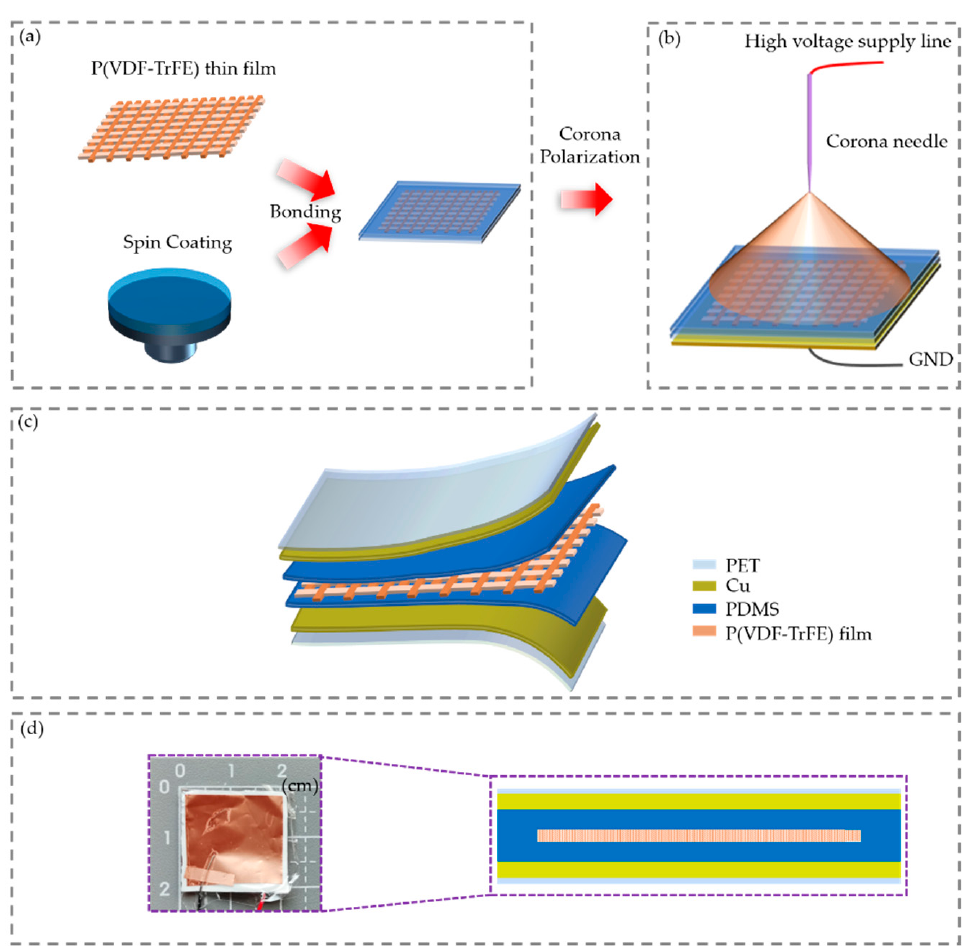
Figure 2. Schematic procedure for fabricating the flexible sensor. ( a ) PDMS sealing as the protective layers and electret layers. ( b ) Corona polarization. ( c ) Diagram of the sensor. ( d ) A sample measuring 2 × 2 cm 2 (left) and a cross-sectional diagram of the sensor’s structure (right).